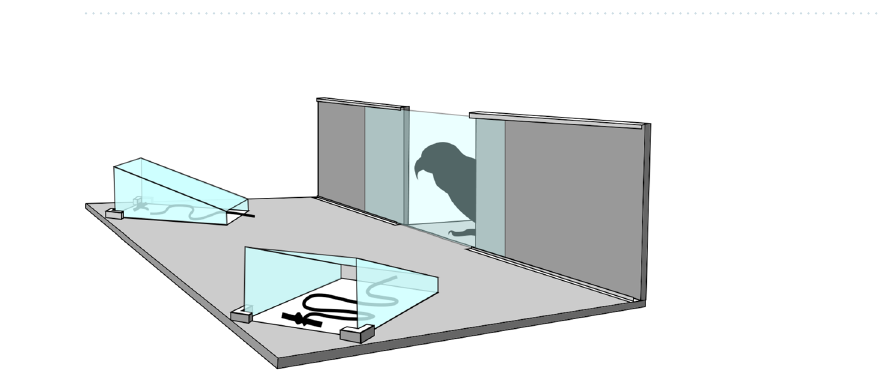
Table 5. Individuals’ hatch dates, sex, and participation in the two experiments. All subjects were parent reared.